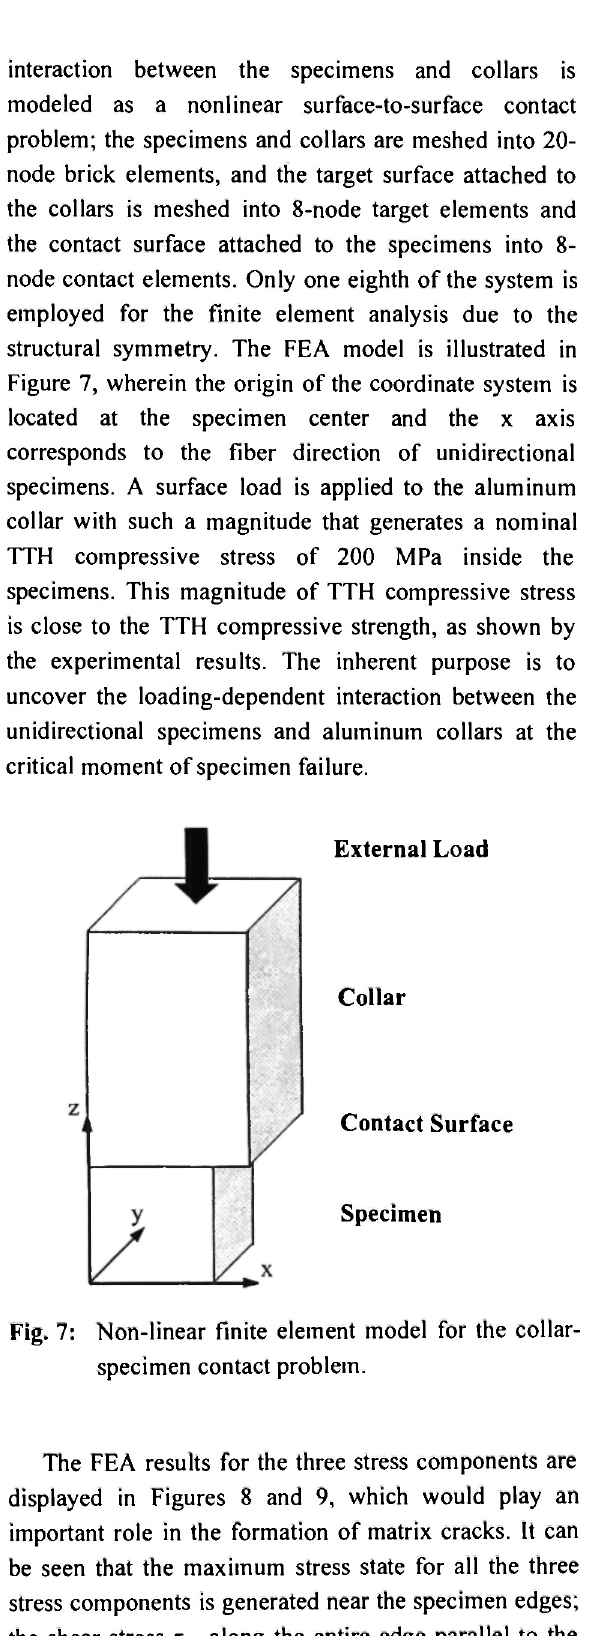
Fig. 7: Non-linear finite element model for the collar- specimen contact